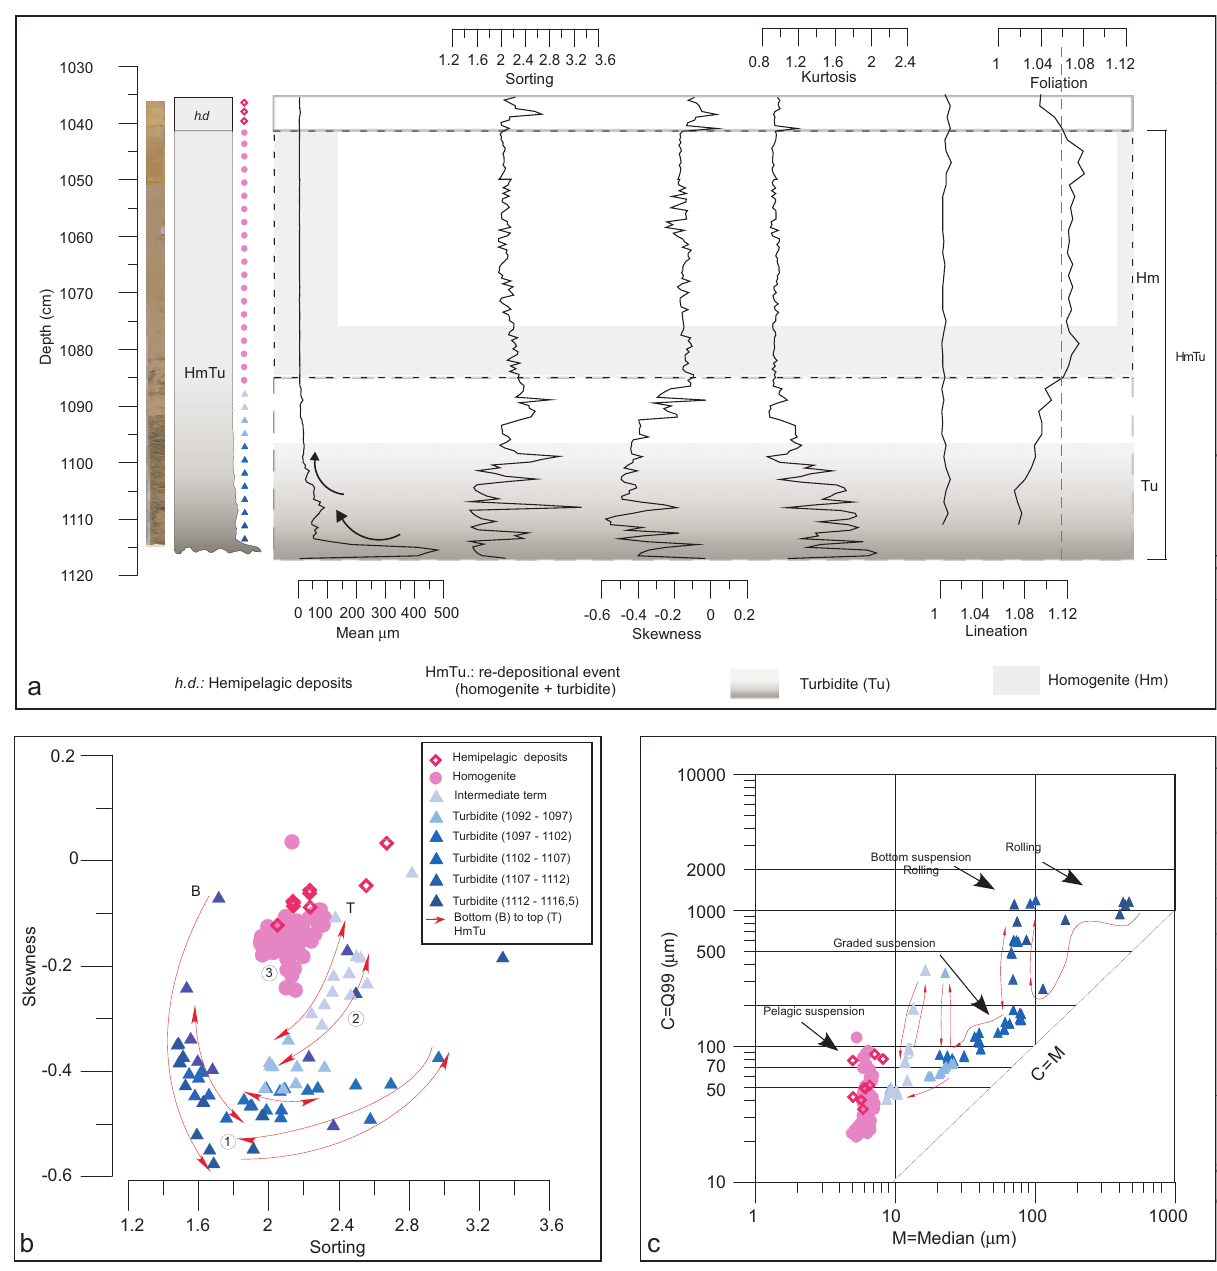
Figure 3. Textural characterization of Homogenite+Turbidite (HmTu) B (1035-1115 cm; location on Figure 2). a) main granulometric pa- rameters and MSA values; b) Sk index vs. So index bottom-to-top path; c) bottom-to-top path on Passega [1964]’s diagram. All textural pa- rameters show a sharp break between turbiditic lower part and overlying